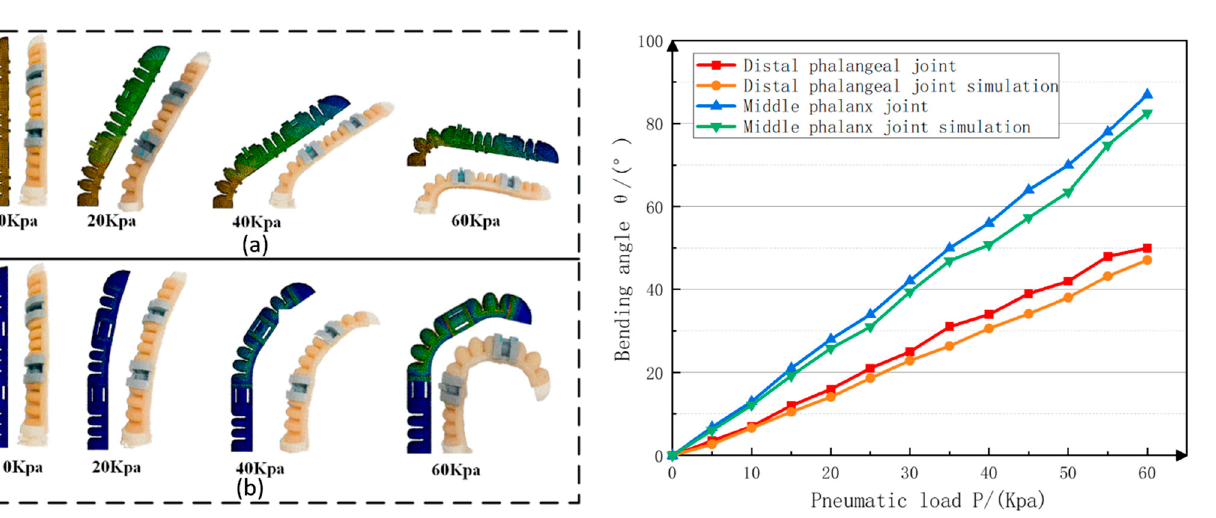
Figure 14. Thumb distal phalanx joint bending experiment: ( a ) no restrictions (Compare with simu- lation model); ( b ) only flexible steel plate; ( c ) confinement ring and flexible steel plate work together.